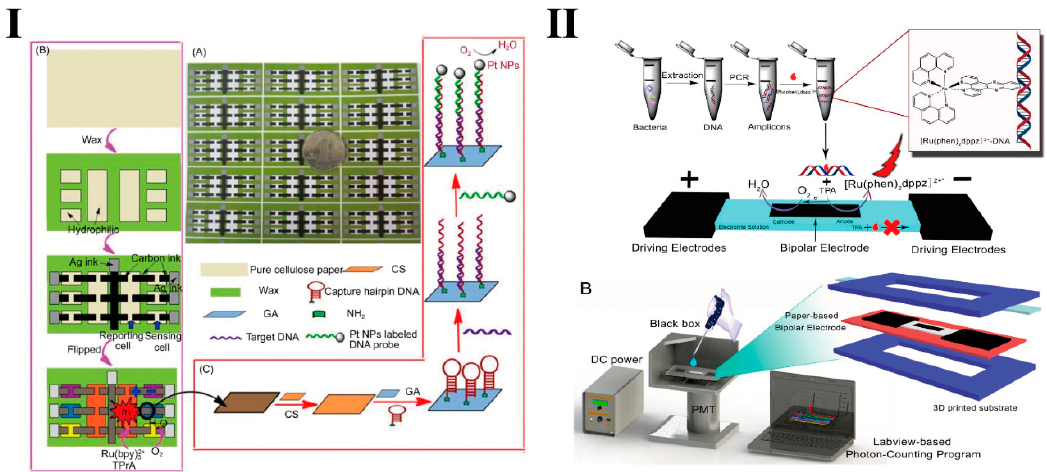
Figure 6. ( I ) Multi-channel paper-based bipolar electrode based on Ru(bpy) 32+ and TPrA reaction for pathogenic DNA detection. Reproduced with permission from [113], published by Science China Press and Springer-Verlag Berlin Heidelberg, 2015. ( II ) Schematic of paper-based bipolar electrode electrochemiluminescence (pBPE-ECL) analysis system for sensitive detection of pathogenic bacteria. Reproduced with permission from [67], published by American Chemical Society, 2016.